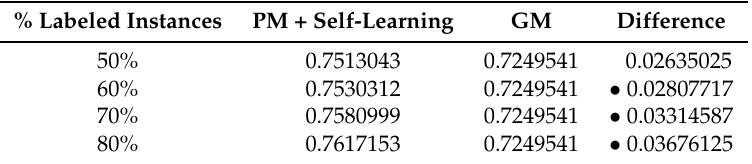
Table 8. D3: WISDM dataset accuracies for varying % of labeled instances with self-learning (PM + self-learning) and the General Model (GM).